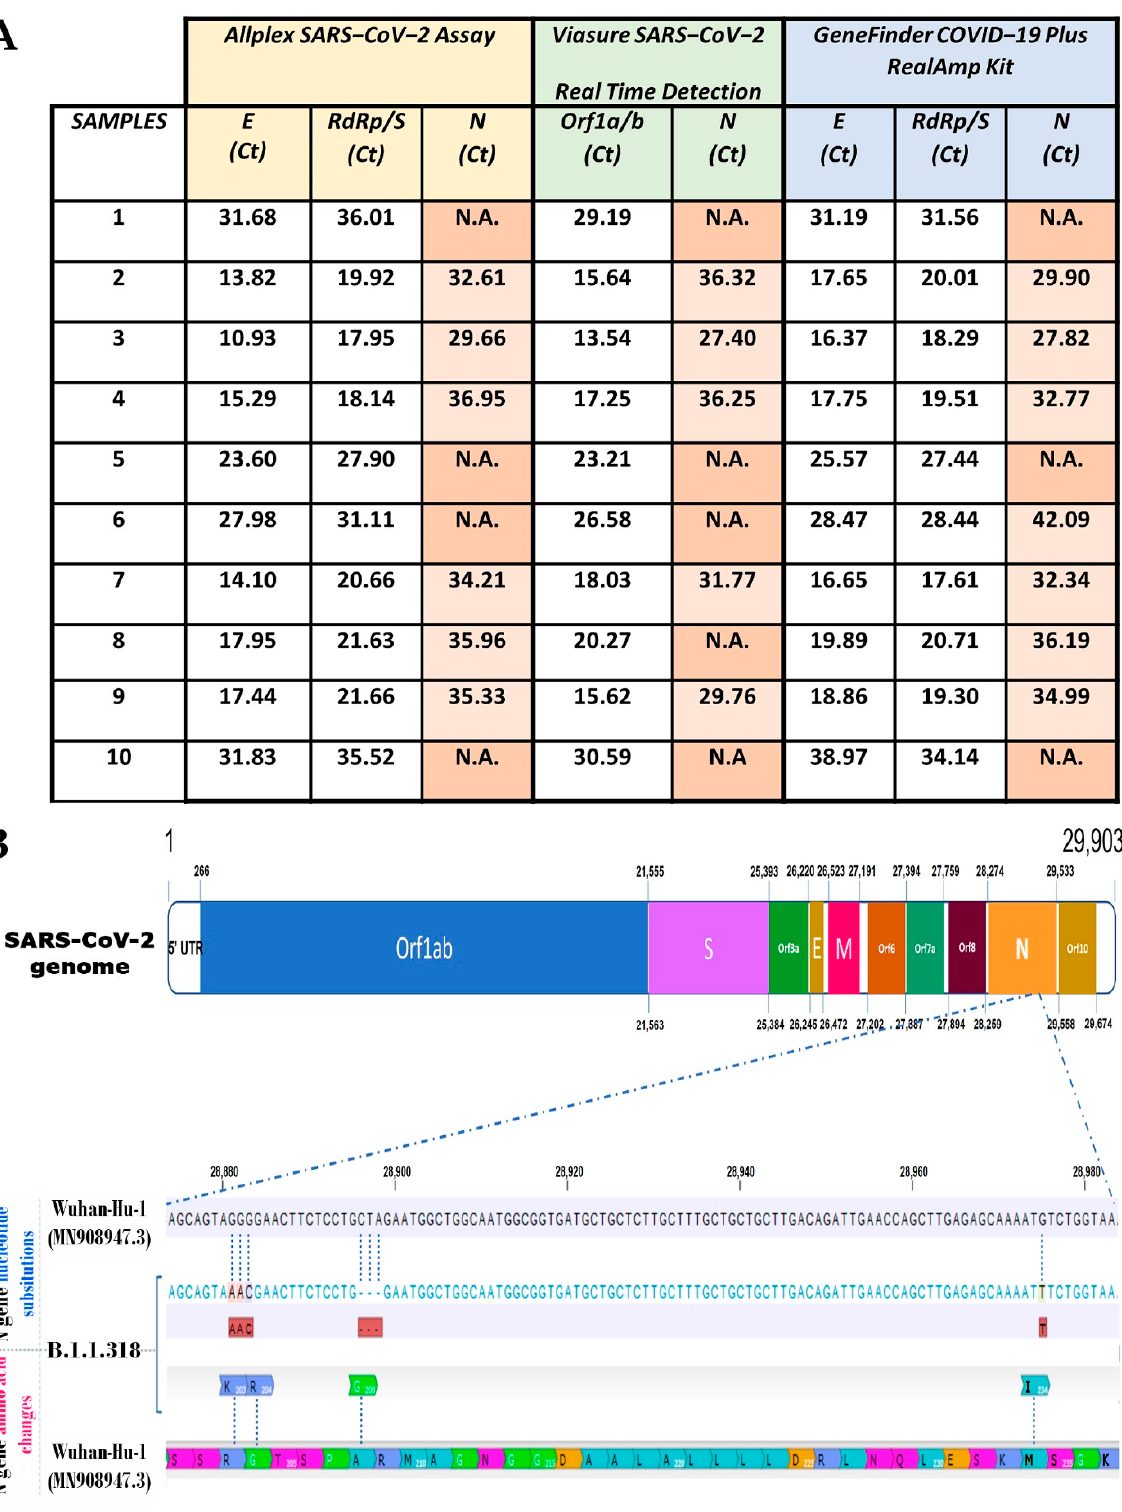
Figure 2. ( A ) The 10 random samples out of 120 that were infected with the B.1.1.318 strain showed similar N gene amplification delays or failures when tested with all three detection kits in parallel. ( B ) Mutations of the N gene sequence of B.1.1.318 isolates that affect primer–probe annealing.